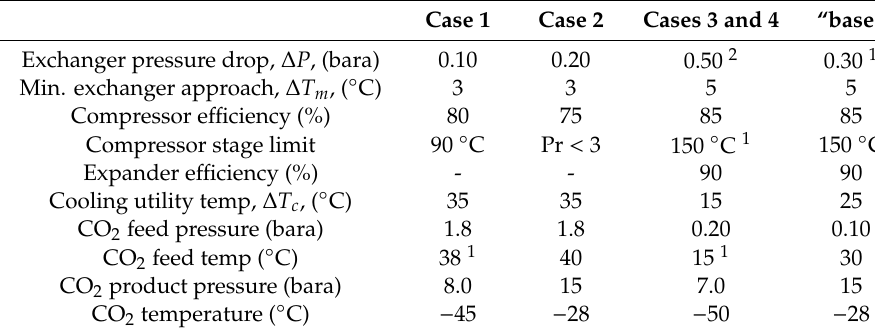
Table 1. Summary of modelling